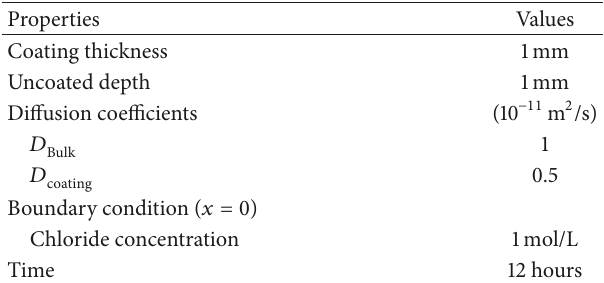
Figure 2: Exact solution and concentration profiles solved from the approximate delta function. Table 2: Setup used for the coating effect simulation of Fick’s law. Properties